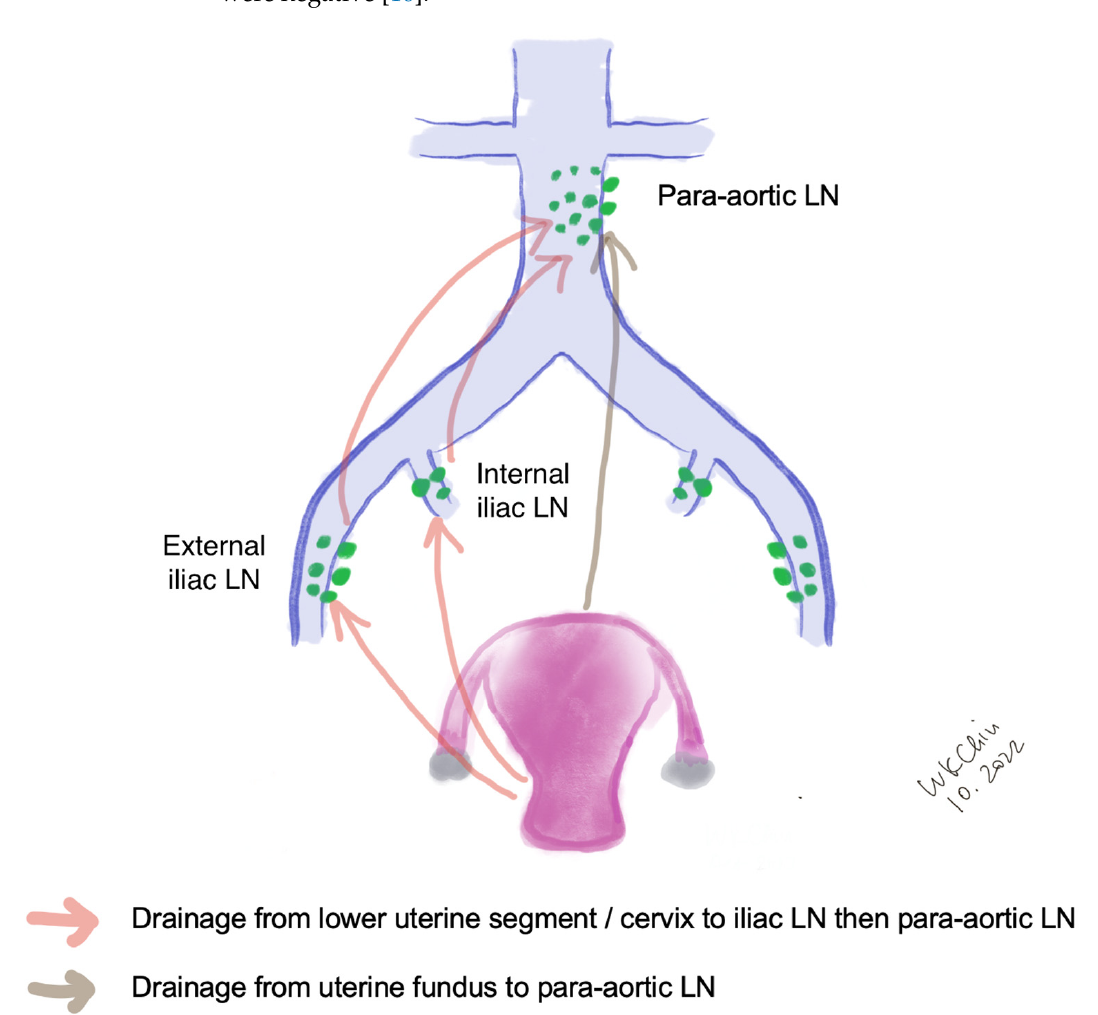
Figure 1. Lymphatic drainage of endometrial cancer. (LN, lymph nodes)